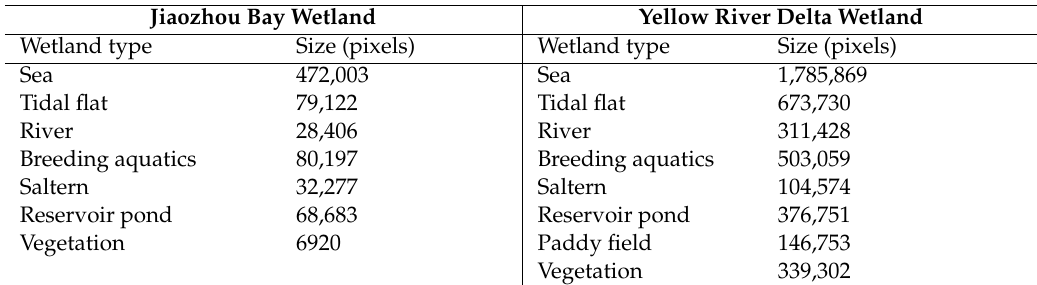
Table 1. Sample size for each wetland type in two study